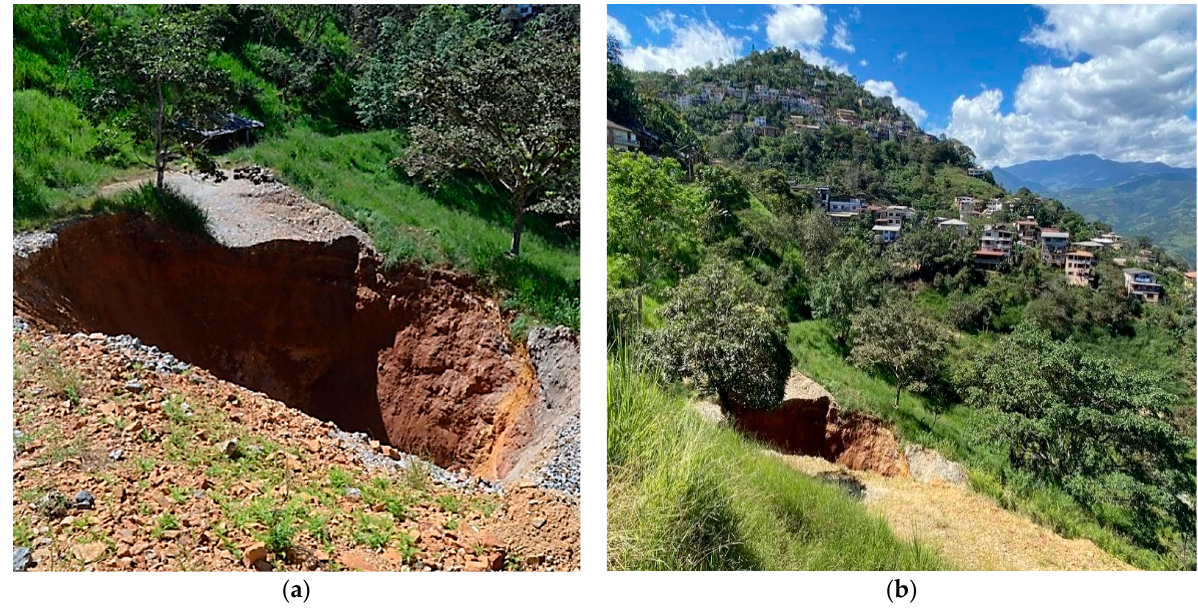
Figure 3. Sinkhole in the province of El Oro, city of Zaruma. ( a ) Sinkhole formation; ( b ) houses at risk due to sinkhole formation.